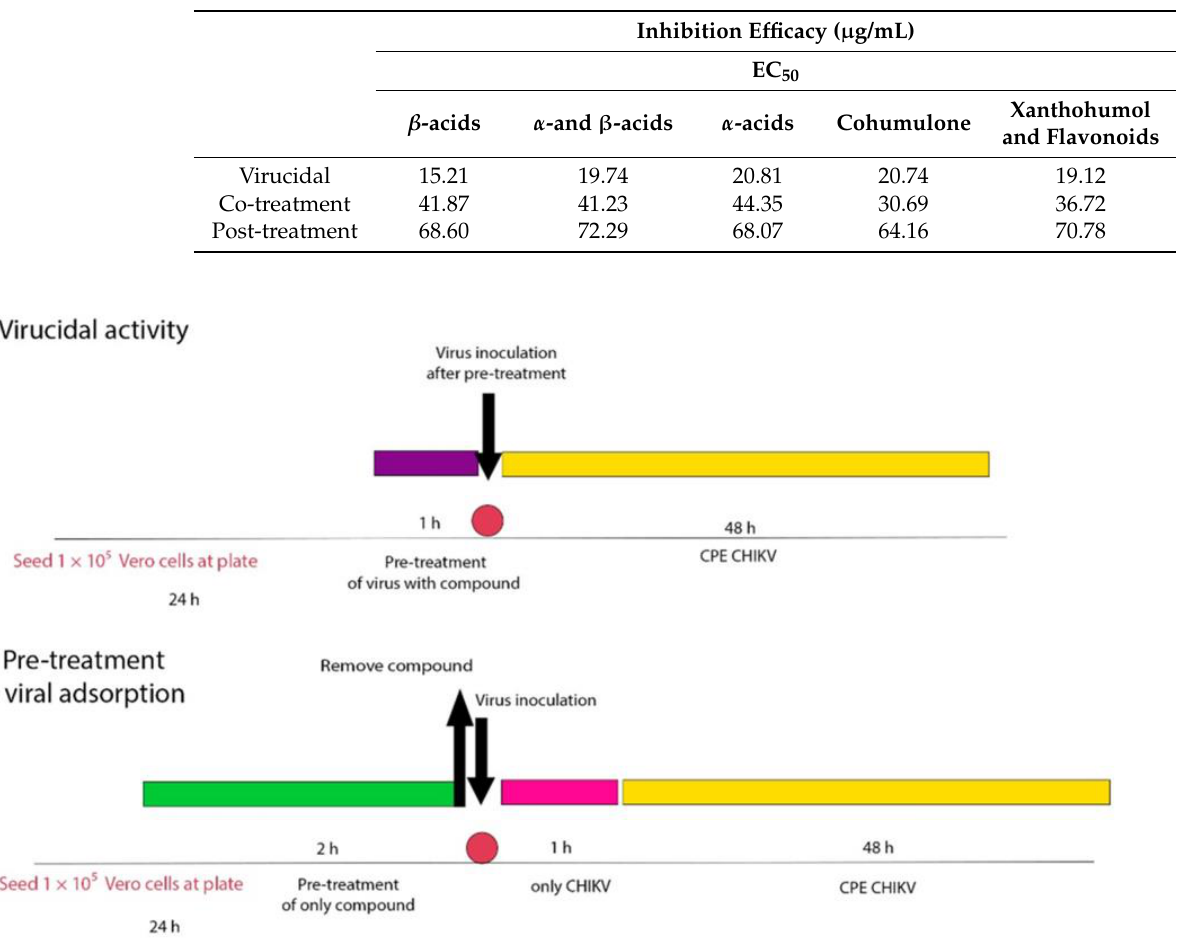
Figure 3. Schematic of antiviral assay at different stages of virus infection. ( A ) Virucidal assay that consists in pre-treatment of virus with compounds followed by inoculation of the treated virus to the cells; ( B ) pre-treatment assay: addition of the compounds at 2 h prior to virus infection; ( C ) co- treatment assay: virus incubated with the compounds at 37 °C; ( D ) post-treatment assay: addition of the compounds at 1 h post-viral infection; CPE — cytopathic effect, CMC — carboxymethyl cellu- lose (the colors were used to differentiate each step of inoculation, there are no specific color mean- ings). Table 2. Inhibition efficacy (EC 50 ) of hops compounds in Vero cell lineages. Inhibition Efficacy (µg/mL) EC 50 β -acids